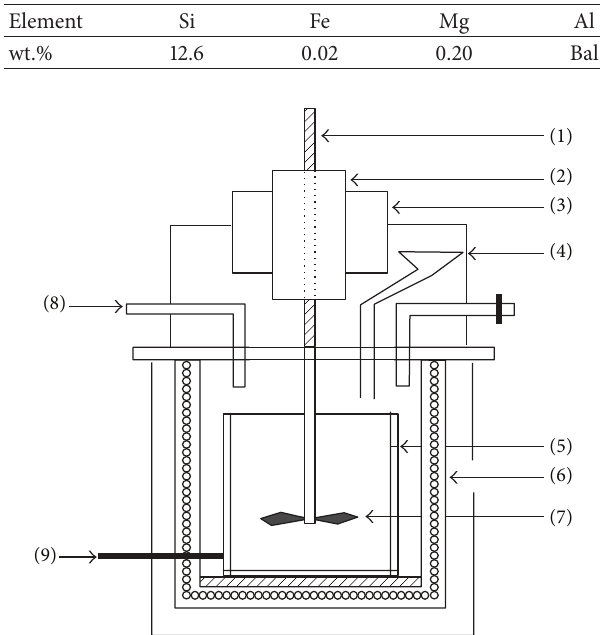
Figure 1: Schematic of modified two-stage stir casting setup. (1) Stirrer spindle, (2) sliding mechanism with impeller position control unit, (3) electric motor, (4) sprue, (5) crucible, (6) electric